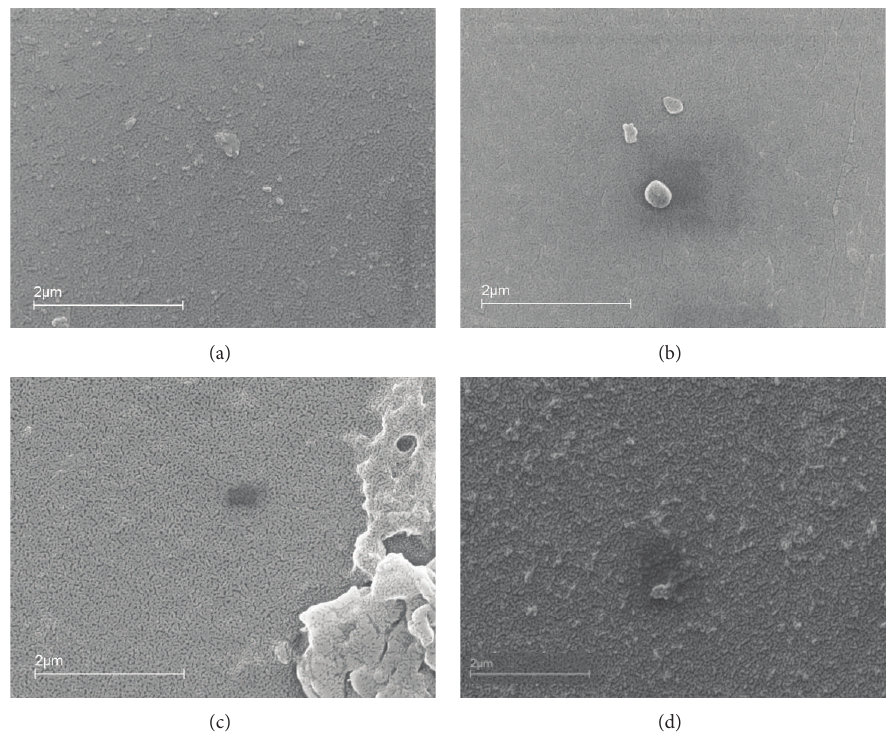
Figure 3: SEM images of (a) PANI B, (b) P4ADPA B, (c) P4ADPA/SSA, and (d)